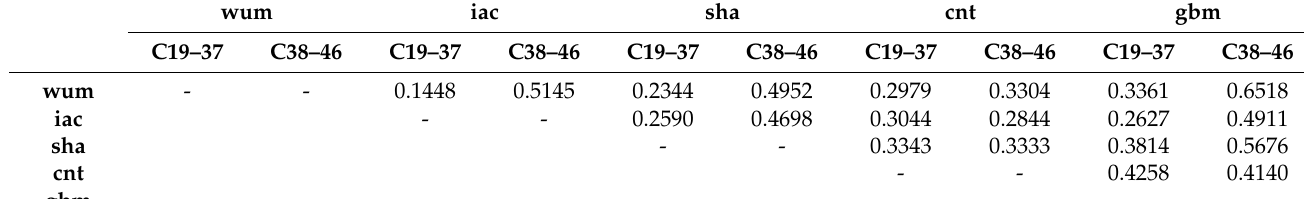
Table 4. STD of the BDS-3 precise clock differences among five products (units: ns).